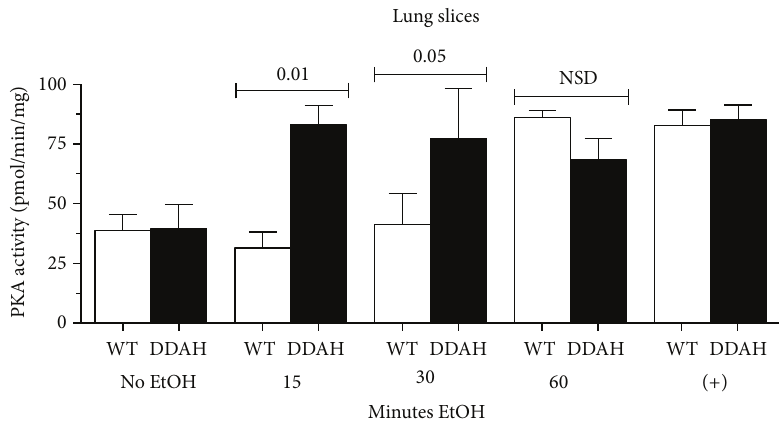
Figure 6: Alcohol-stimulated increases in lung slice PKA activity are enhanced in DDAH mice. Precision-cut lung slices from both wild type (WT) and dimethylaminohydrolase (DDAH) expressing mice were treated with alcohol, and their maximal PKA activity was recorded. Alcohol (EtOH; 100mM) significantly stimulated PKA in slices from both mice at 1hr. Alcohol-stimulated PKA was earlier in DDAH (15– 30 min)versusWTlungslices(1 hr).Positivecontrol(+)representsa30 mintreatmentwith10 𝜇 M8Br-cAMP.BarsrepresentSEMoftriplicate separate experiments ( 𝑛 = 3